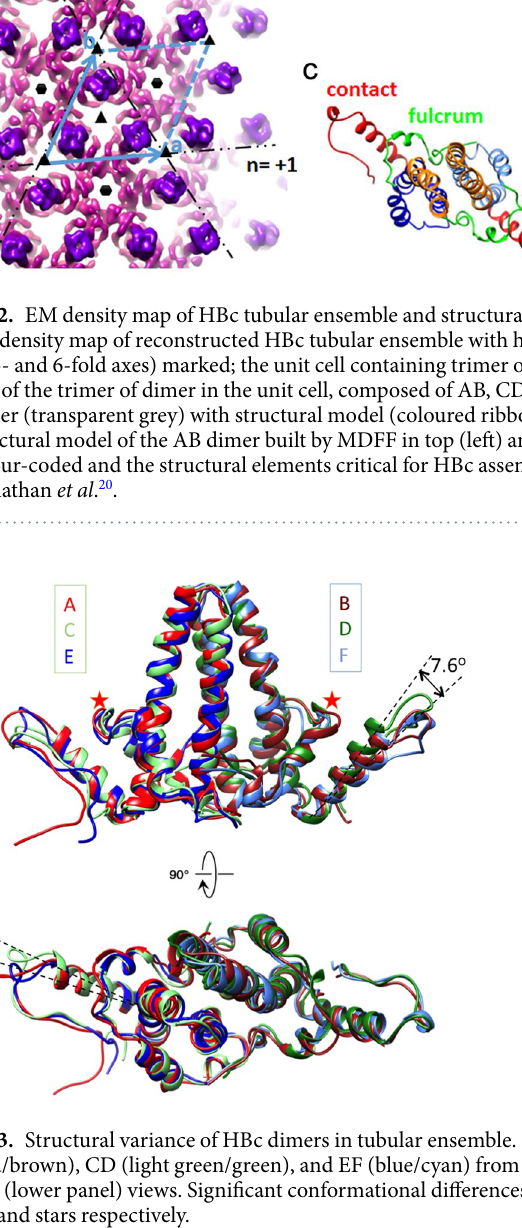
the tubular ensemble. Structural comparison with other type of high-order assembly forms, including the T = 4 icosahedral capsid and a sheet-like ensemble, revealed that the conformations of HBc dimers in these different HBc assembly forms contain important structural differences that alter the inter-dimer interactions allowing for the formation of alternate assembly forms. Based on structural analyses, we propose a mechanism how BAY 41-4109 transforms the HBc assembly from capsid into tube (Fig. 6). In the presence of BAY 41-4109, the drug induces a conformational change within the HBc dimer to promote a structural transfer from HBc Act to HBc Abb ; by weakening the inter-dimer interac- tions, and destabilizing the capsid thereby driving the assembly into the helical tube ensemble. Alternatively, BAY 41-4109, which is structurally similar to HAP-1 26 , could bind like HAP-1 at the hydrophobic pocket formed by helices α 2, α 4b and α 5 of HBc and helix α 5 of neighbour HBc 27, 31 . Thus BAY 41-4109 induced conformational